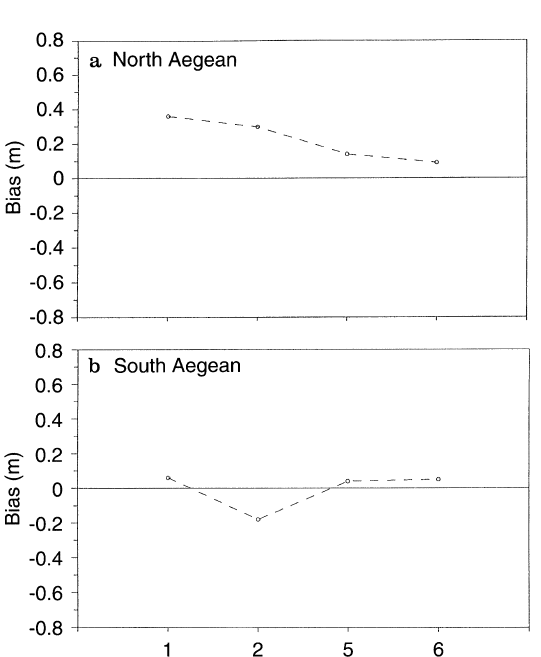
Fig. 12a,b. Bias of compared wave-height results with different wave models (WAM-cy3 v. AUT) a North Aegean; b South